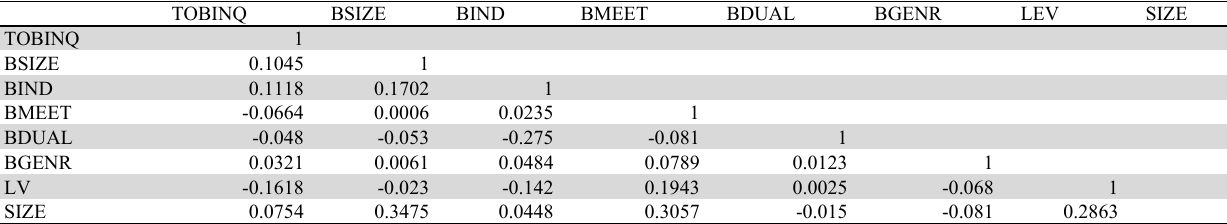
Correlation matrix